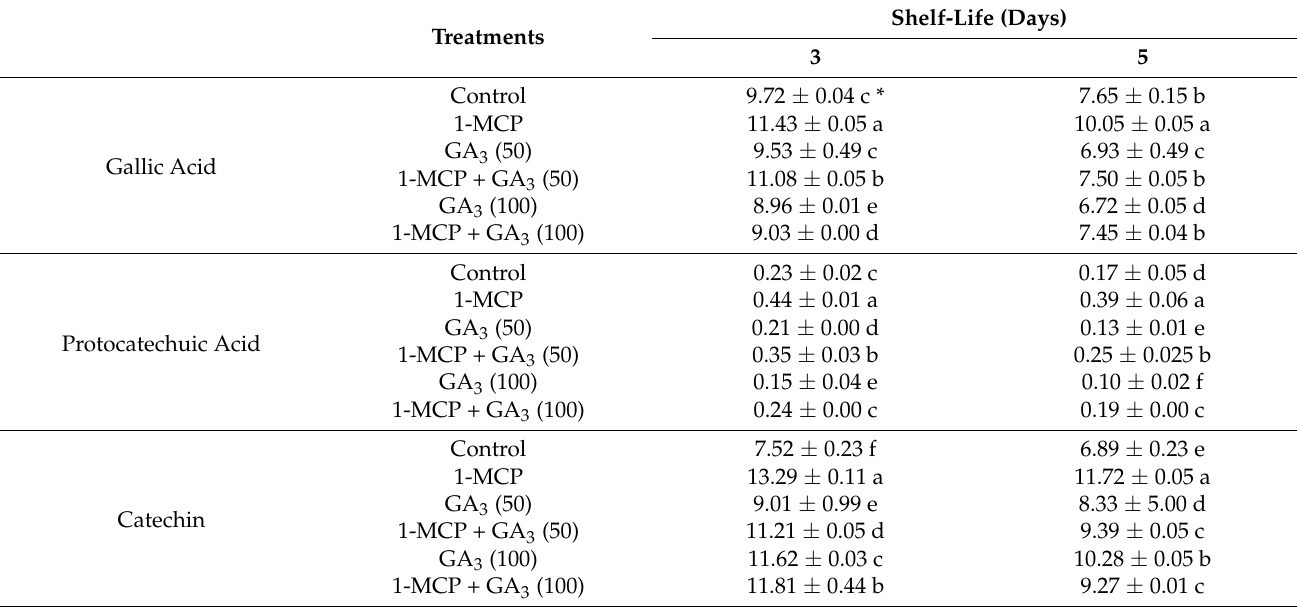
Table 3. Effect of 1-MCP and GA 3 treatments on the gallic, protocatechuic, catechin, and chlorogenic acid contents during shelf-life of strawberry fruits (mg 100 g − 1